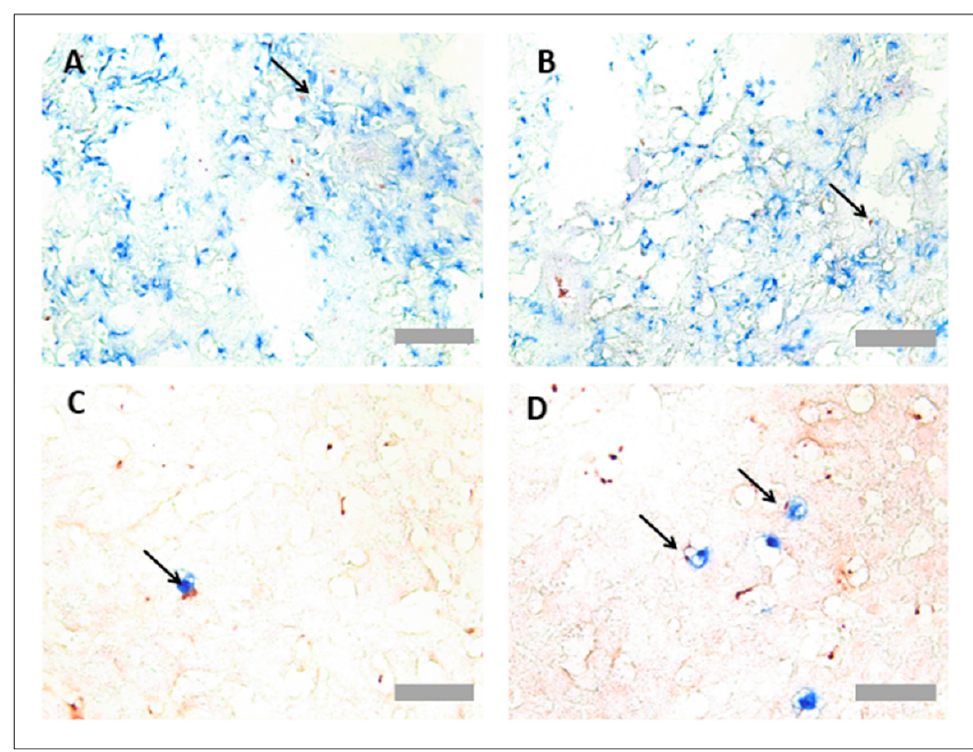
Figure 4. Platelet neutrophil complex multiplex immunohistochemistry in rat lung and liver tissues. Frozen rat tissues were prepared and immunostained with anti-myeloperoxidase (MPO) antibody (ab9535, Abcam, UK) and anti-CD61 antibody (PB9647, Boster, USA), prepared at 1/25 and 1/100 dilutions, respectively. Platelets appear red, and neutrophils appear blue. Representative images of platelet neutrophil complex (PNC) staining in rat lung tissue ( A , B ) and rat liver tissue ( C , D ). Arrows denote CD61+ MPO+ events. Scale bar = 100 μ m in Figures ( A , B ) (×20 objective) and 30 μ m in Figures ( B , C ) (×63 objective).